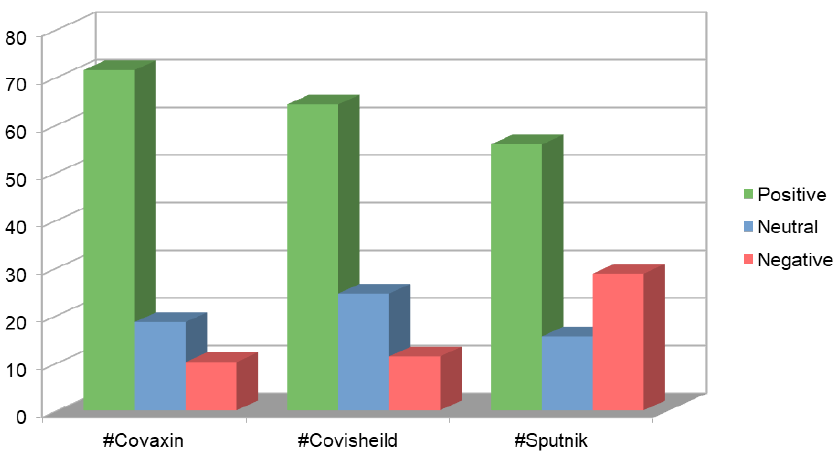
Figure 9. Sentiment polarity distributions for #covaxin, #covishield, and #sputnik vaccines (%age) .